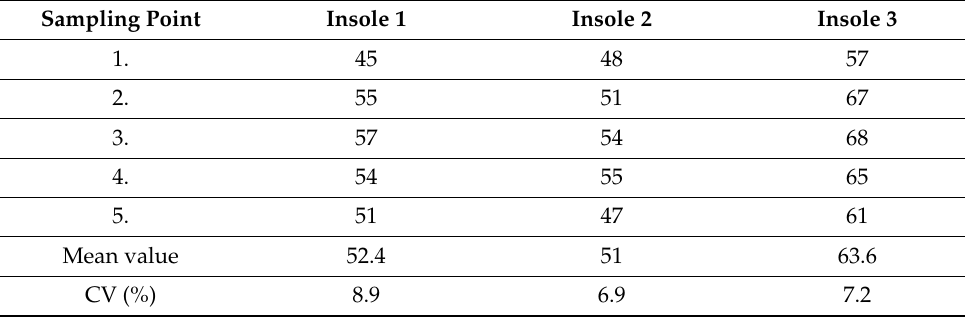
Table 1. Shore D results for previous insole